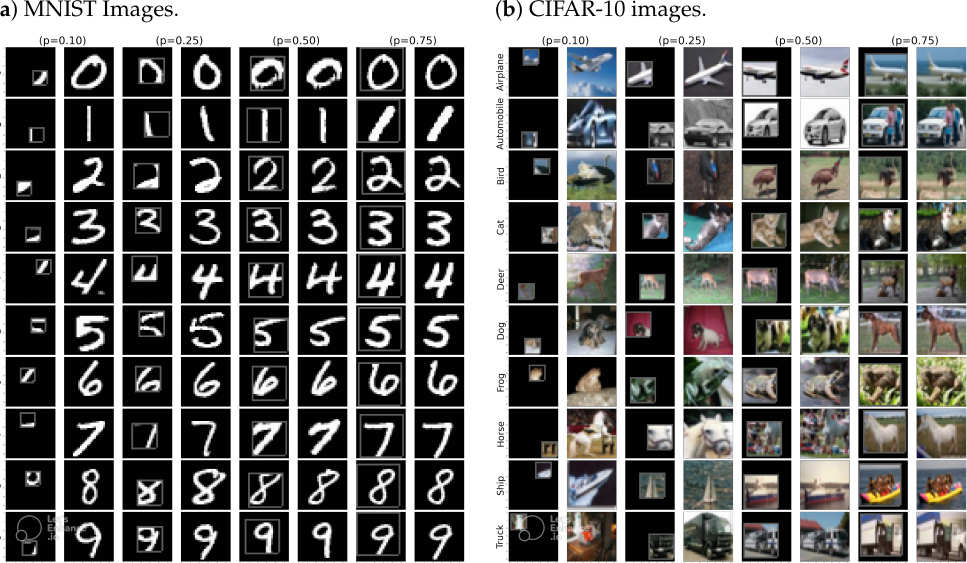
Figure 5. The Cutout-CL outputs where the leave-out percentage is defined by p . The rows show side-by-side depiction of the compressed and original images, while the columns represent different